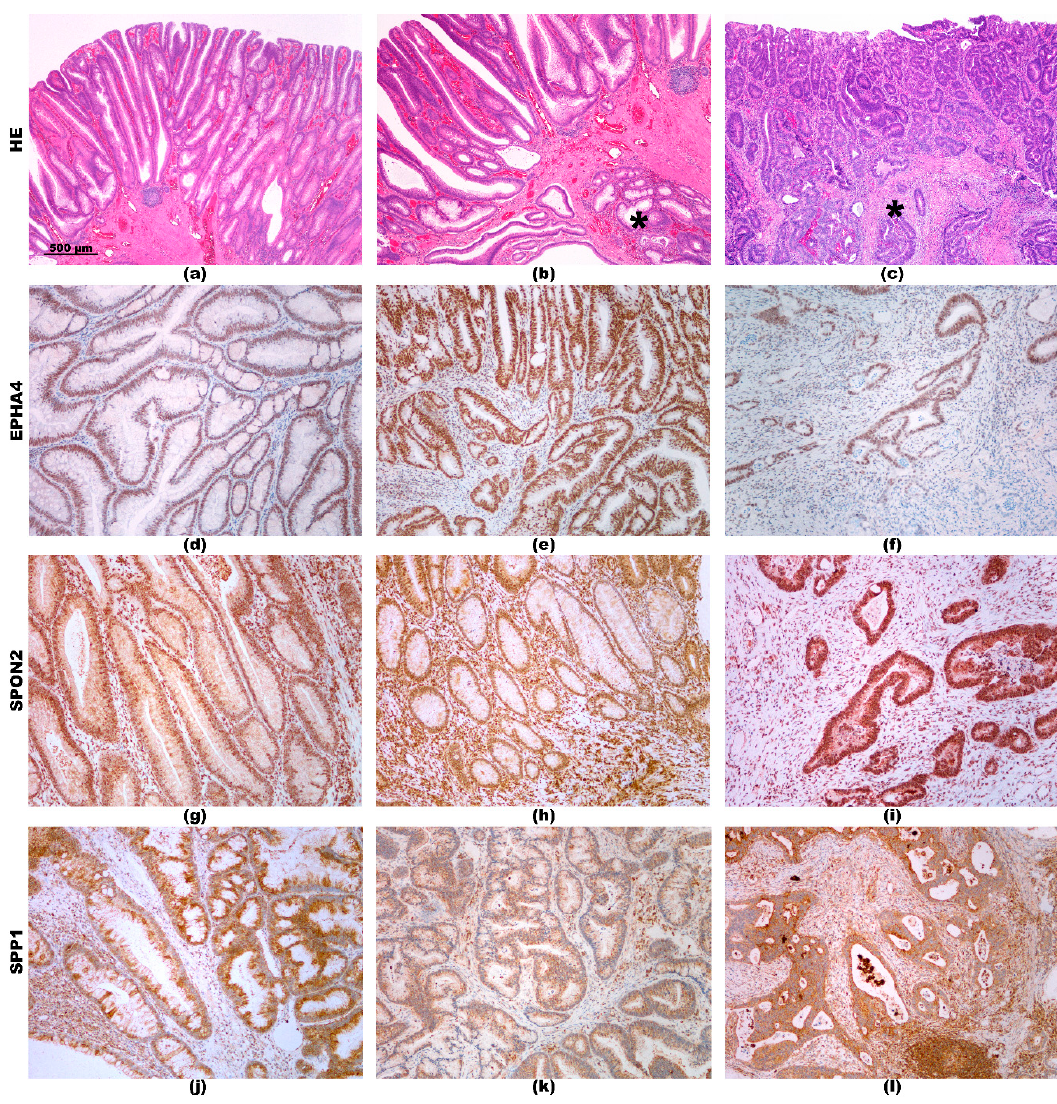
Figure 3. ( a ) Adenoma; ( b ) adenoma with epithelial misplacement—epithelial misplacement in the submucosa is marked by asterix *; ( c ) adenoma with early carcinoma; invasive carcinoma in the submucosa is marked by asterix *. HE staining, orig. magnification 4 × . EPHA4: Mild positive reaction in epithelial cells in adenoma ( d ). More intensive reaction in epithelial cells and in the stroma in epithelial misplacement ( e ). Focal reaction in carcinoma cells and in the stroma of invasive carcinoma ( f ). SPON2: Positive reaction in epithelial cells and in the stroma in adenoma ( g ). Positive reaction in epithelial cells and in the stroma in epithelial misplacement ( h ). Strong reaction in carcinoma cells and positive reaction in the stroma of invasive carcinoma ( i ). SPP1: Positive reaction in epithelial cells and mild reaction in the stroma in adenoma ( j ). Positive reaction in epithelial cells and in the stroma in epithelial misplacement ( k ). Strong reaction in carcinoma cells and in the stroma of invasive carcinoma ( l ). Immunohistochemistry, orig. magnification 10 ×